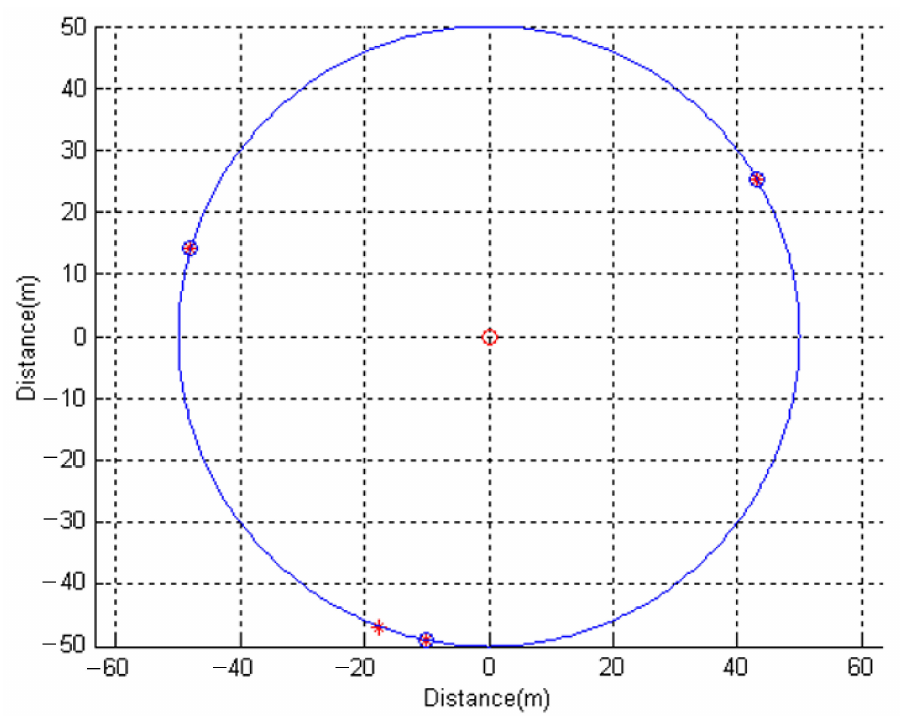
Figure 6. The MSE of the reference node is greatly reduced after selection. * stands for that node is not selected.